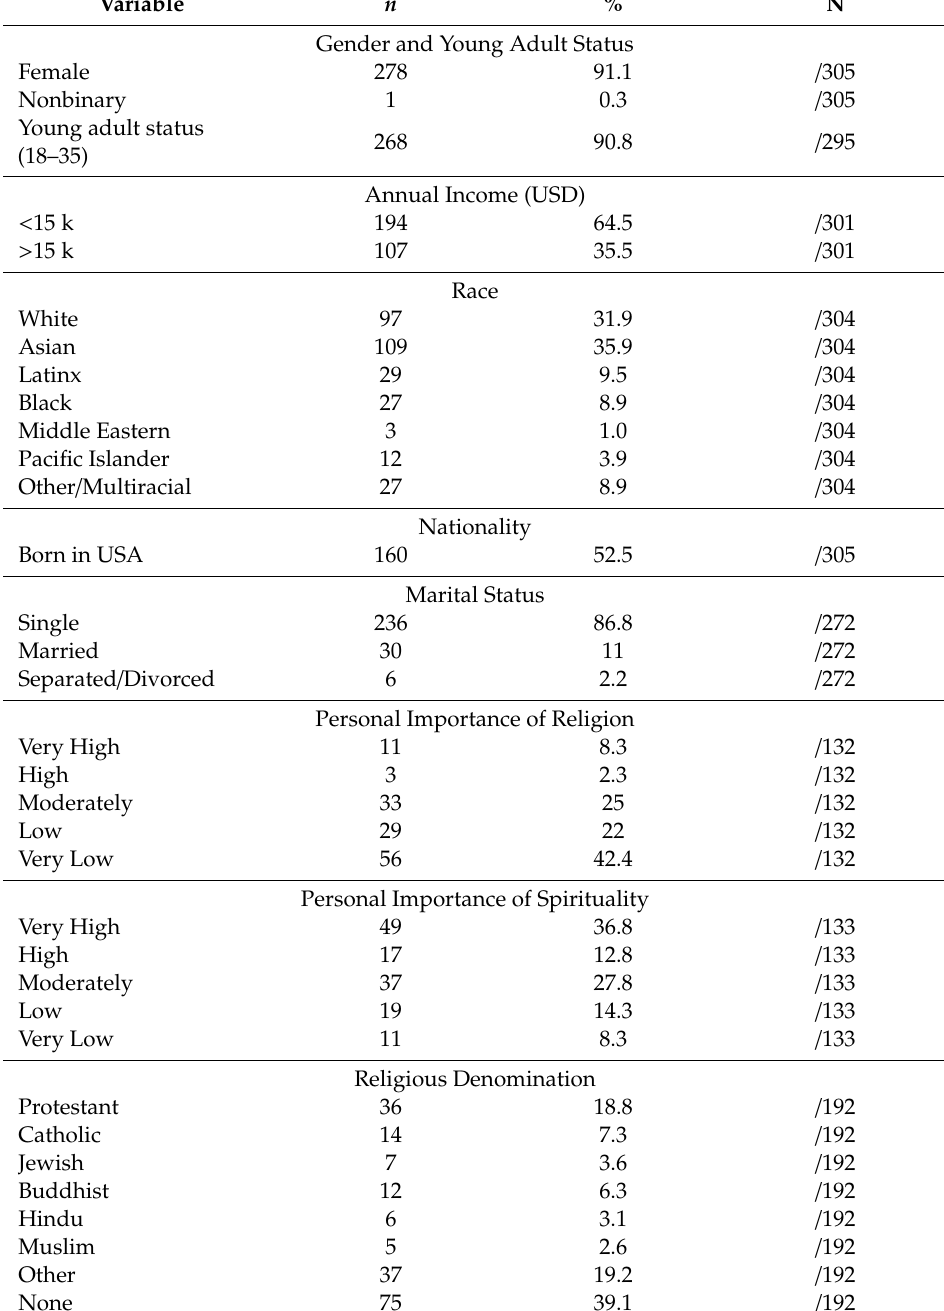
Table 2. Demographic Characteristics of Participants at Baseline—Across all